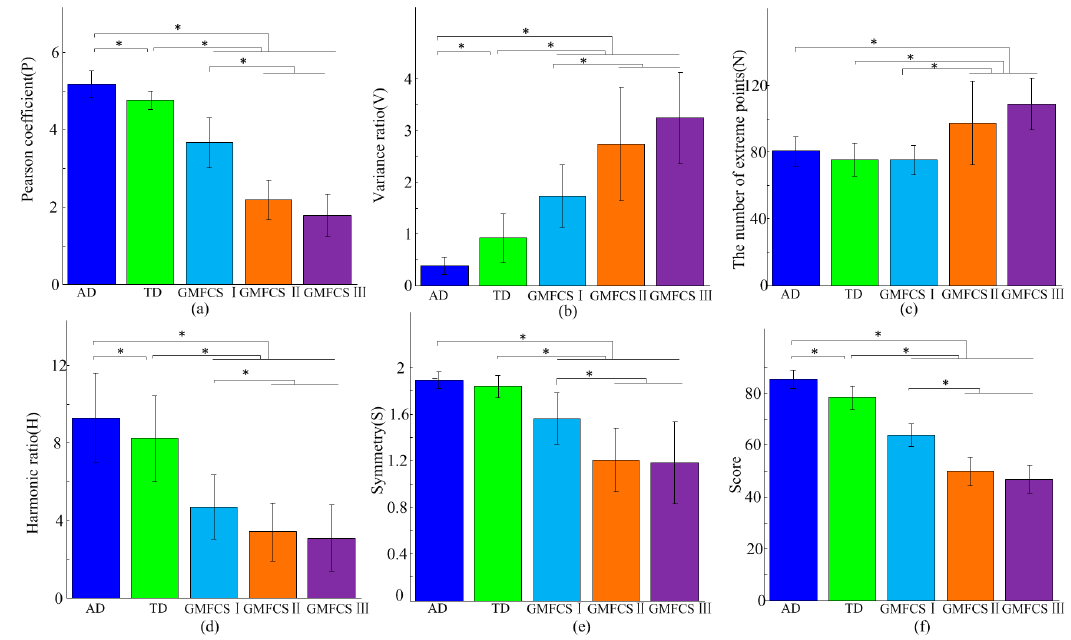
Figure 7. Five features and assessment scores of all subjects. ( a ) Pearson coefficient (P); ( b ) Variance ratio (VR); ( c ) The number of extreme points (N); ( d ) Harmonic ratio (HR); ( e ) Symmetry (S); ( f ) Assessment scores. “*” indicates statistically significant differences.